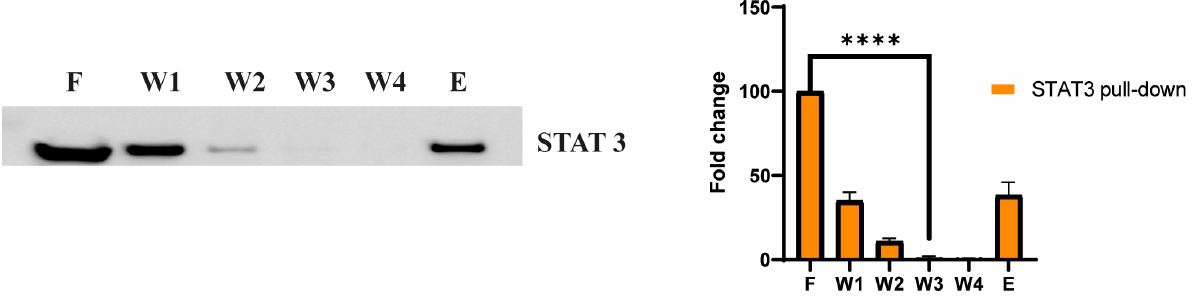
Figure 6. Pull-down assay: STAT3 capture from TT cell extracts with adefovir dipivoxil affinity agarose by pull-down assays. Supernatant (F) corresponds to the cell extract after incubation with each type of affinity bead, which was used as a control of the input material, and the gels were washed four times (W1, W2, W3 and W4). Bound STAT3 (E) was eluted with SDS-PAGE protein loading